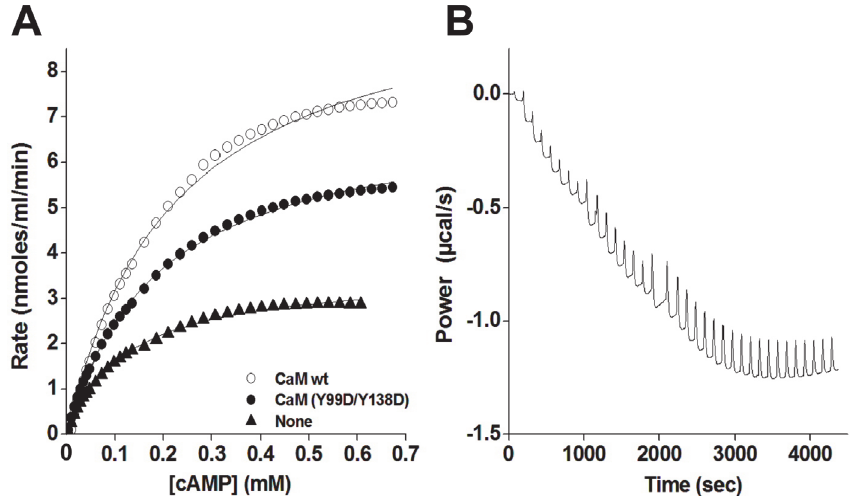
Fig 9. Effect of different CaM species on the kinetics of PDE1 determined by isothermal titration calorimetry. ( A ) The plot presents the PDE1 activity (normalized for 0.04 units of enzyme) at increasing concentrations of cAMP in the absence ( filled triangles ) and presence of wild type CaM ( open circles ) or CaM (Y99D/Y138D) ( filled circles ) (3.8 μ M) in a buffer containing 50 mM imidazol-HCl (pH 7.5), 200 mM NaCl, 5 mM MgCl 2 , 0.4 mM EGTA, and 0.5 mM CaCl 2 using ITC as described in Materials and Methods setting the micro-calorimeter chamber 37°C. ( B ) The trace corresponds to a typical experiment showing the rate of heat produced by PDE1 over time after injections of different pulses of cAMP from which the activity of the enzyme can be derived as described in Materials and Methods. This particular trace corresponds to an experiment performed in the absence of CaM using 0.04 units of PDE1. Similar traces were obtained in other conditions tested.